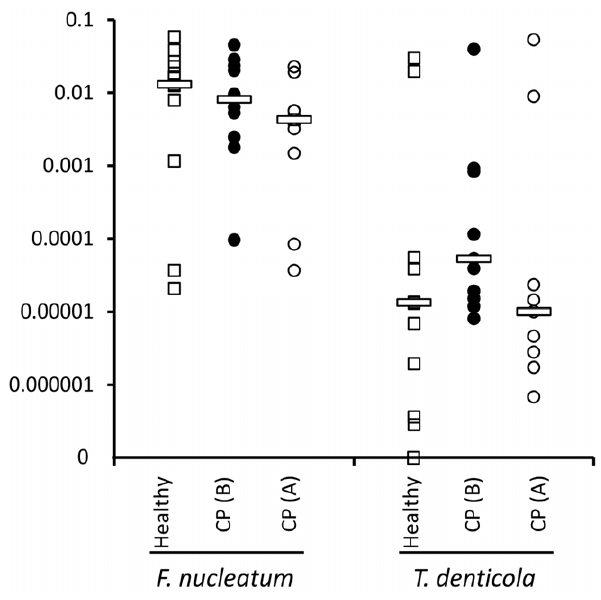
Figure 4. Relative amounts of F. nucleatum and T. denticola in saliva. The relative proportion of F. nucleatum or T. denticola among the total bacteria in saliva was determined by real-time PCR of 16S rRNA. Bars indicate median values.